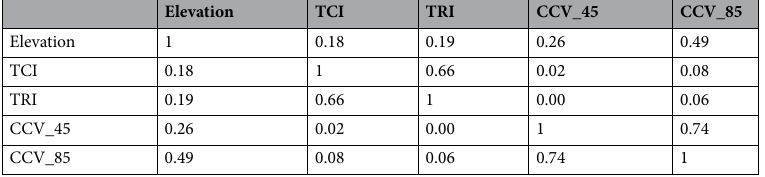
Table 3. Correlation matrix among the tested variables for habitat suitability: elevation, topographic heterogeneity (as TCI, topographical intrinsic complexity, and TRI, terrain ruggedness) and climate change velocity for both rcp 4.5 (CCV_45) and rcp 8.5